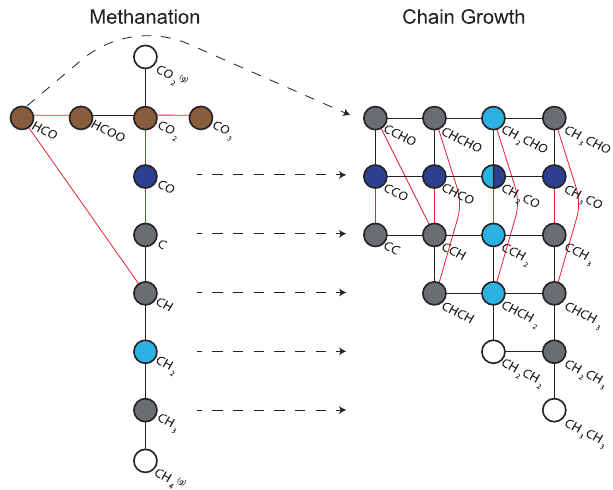
Fig. 5 Schematic overview of elementary reaction steps in CO 2 hydrogenation on Co/TiO 2 . The white nodes indicate reactant and product molecules, the brown nodes correspond to reaction intermediates that were detected ME DRIFTS on both CoO and metallic Co. The light blue node for CH 2 on the left side was detected only on CoO and the dark blue node for CO only on metallic Co. On the right side the C – C coupled species with either CH 2 or CO are colored light blue or dark blue respectively. Black lines connecting the nodes represent (de)hydrogenation steps and the red lines indicate (de)coupling of an oxygen atom. The arrows with a dotted line represent C – C coupling events. Table 1 Kinetic parameters for Co/TiO 2 .